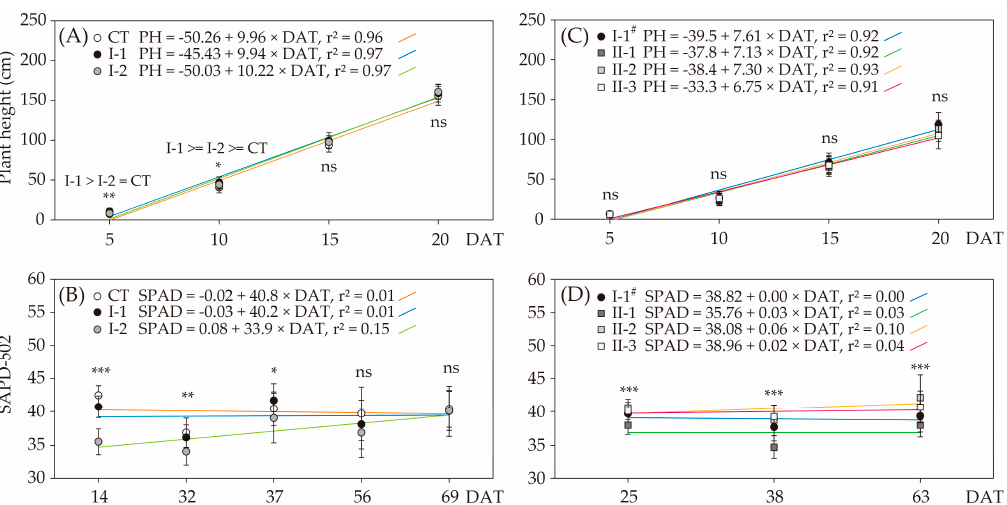
Figure 5. The growth characteristics of netted melon from different nutrient treatments in Experiment I and II. ( A ) Plant height, PH (cm); and ( B ) relative leaf chlorophyll content, SPAD-502, measured from Experiment I. ( C ) Plant height (cm), PH; and ( D ) relative leaf chlorophyll content, SPAD-502, measured in from Experiment II. Statistical significances tested with one-way ANOVA were denoted by asterisk: p < 0.05 *, p < 0.01 **, p < 0.001 ***. Codes and details for the experimental treatments refer to Tables 1 and 2.